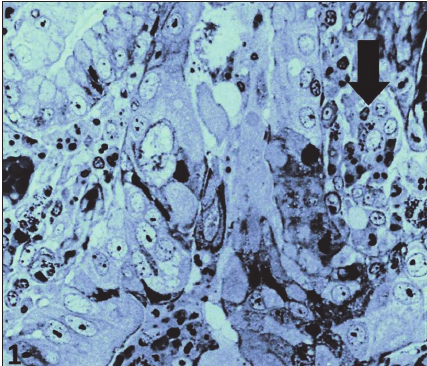
Figure 1: Mast cell surrounded by neutrophils (arrow) in the tumor stroma of gastric adenocarcinoma. (semithin section, ×